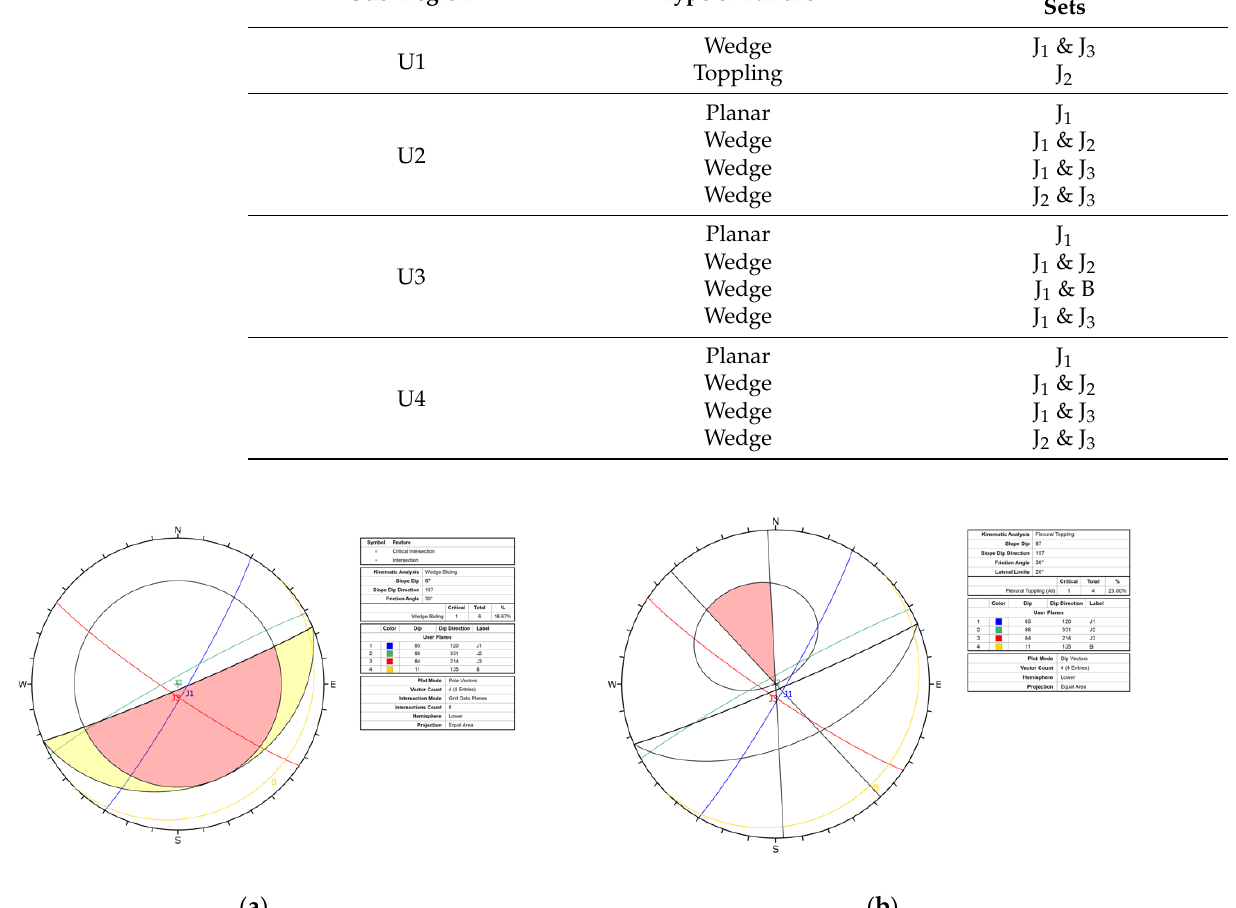
Table 3. A concise review of the kinematic analysis per sub-region.